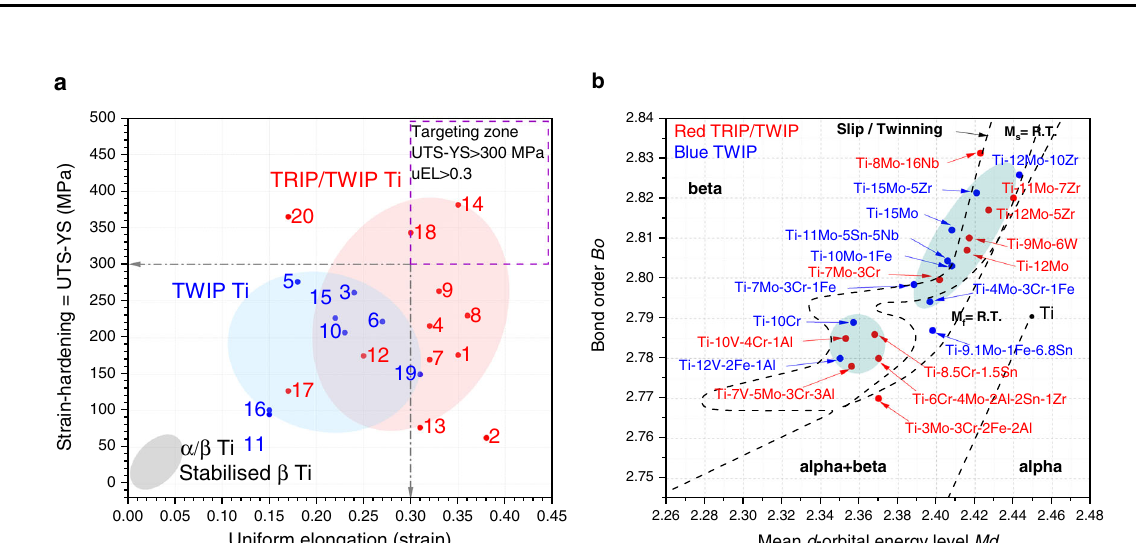
Fig. 1 Mechanical characteristics and TRIP/TWIP alloy compositions. a Strain-hardening vs. uniform elongation, where TRIP/TWIP alloys exhibit the best combination of strain-hardening and tensile ductility. b TRIP/TRIP and TWIP Ti alloys are collectively located onto the Bo--Md phase stability